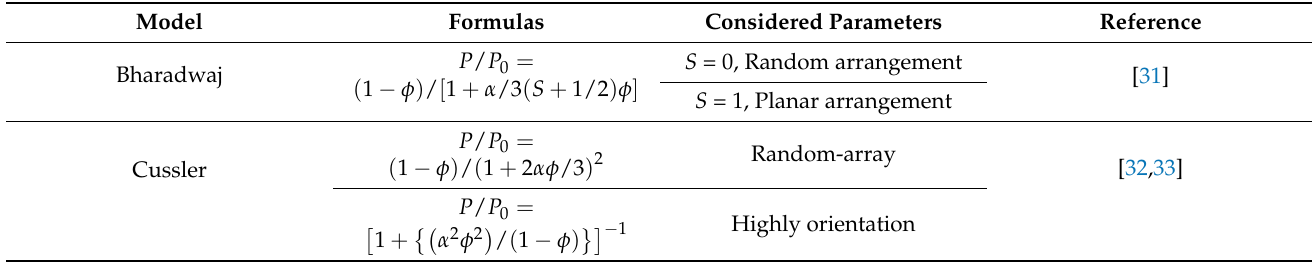
Table 1. Models for predicting barrier properties of nanoclay filled